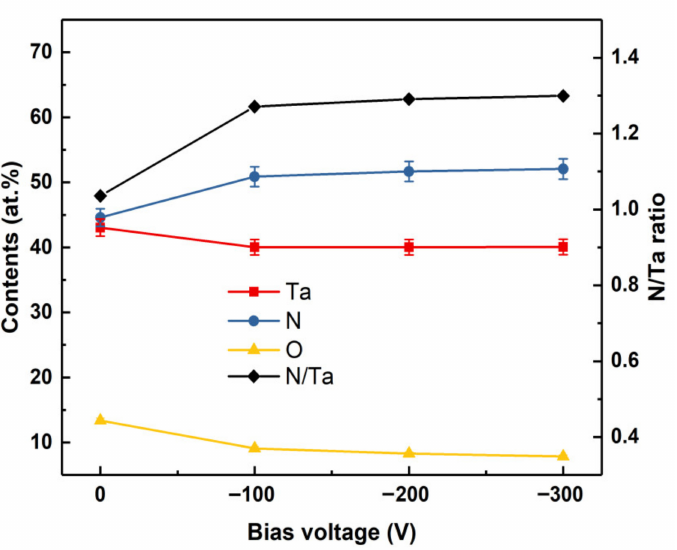
Figure 2. Component contents (by XPS) of the TaN x coatings as a function of the bias